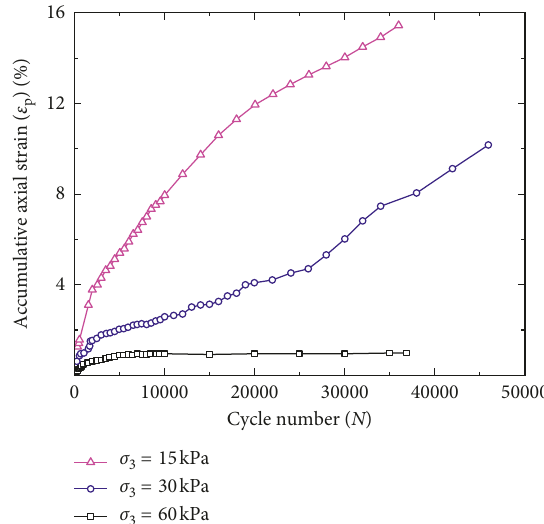
Figure 9: Accumulative axial strain-cycle number curves under different confining pressures ( σ d